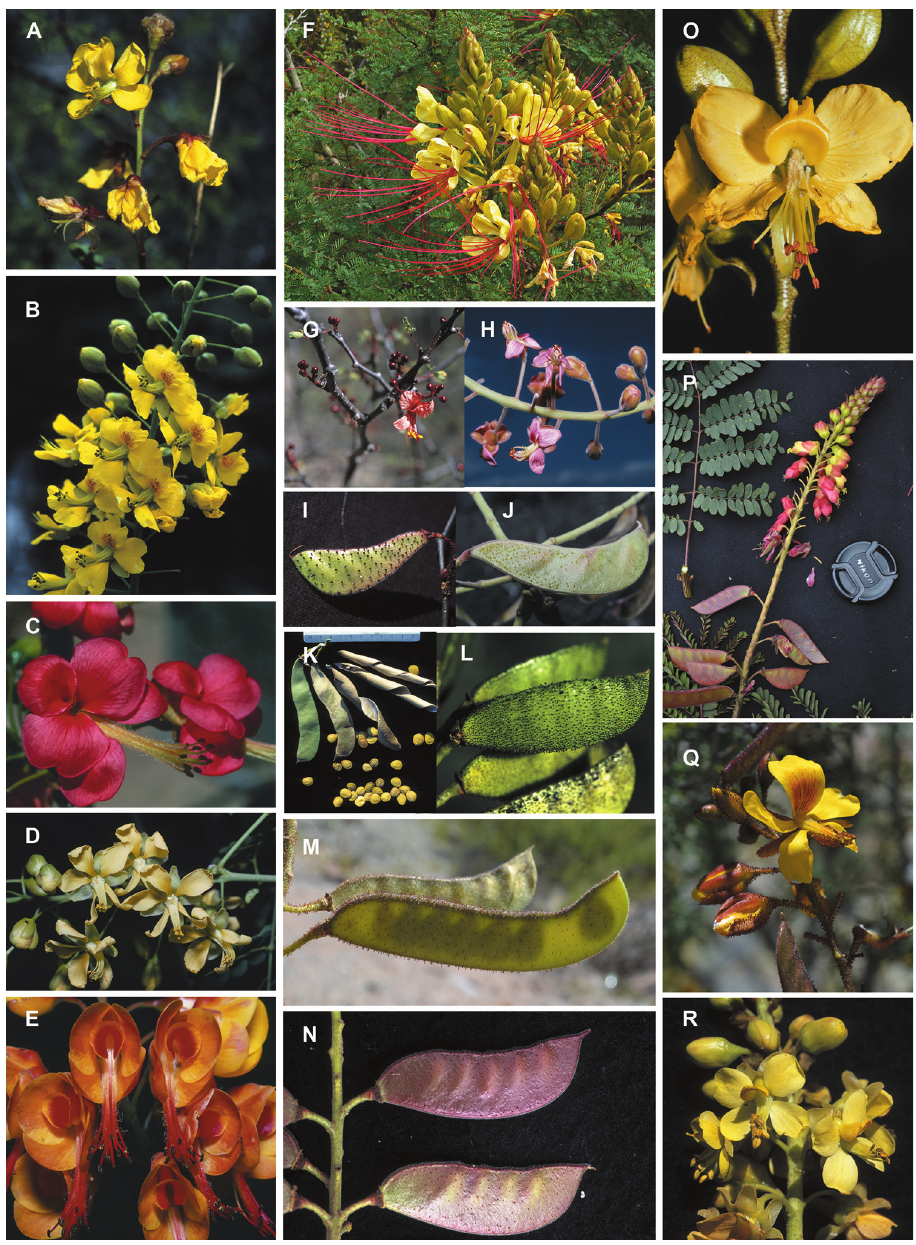
Figure 42. Erythrostemon placidus (Brandegee) E. Gagnon & G. P. Lewis. A flowers (C. E. Hughes, Baja California, Mexico, Lewis 2031 (K)). Erythrostemon mexicanus (A. Gray) E. Gagnon & G. P. Lewis B inflores- cence (C. E. Hughes, San Luís Potosí, Mexico, Hughes et al. 1606 (FHO)). Erythrostemon coccineus (G. P. Lewis & J. L. Contr.) E. Gagnon & G. P. Lewis C flowers (C. E. Hughes, Oaxaca, Mexico, Lewis et al. 1802 (K)). Erythrostemon pannosus (Brandegee) E. Gagnon & G. P. Lewis (captions continued on next